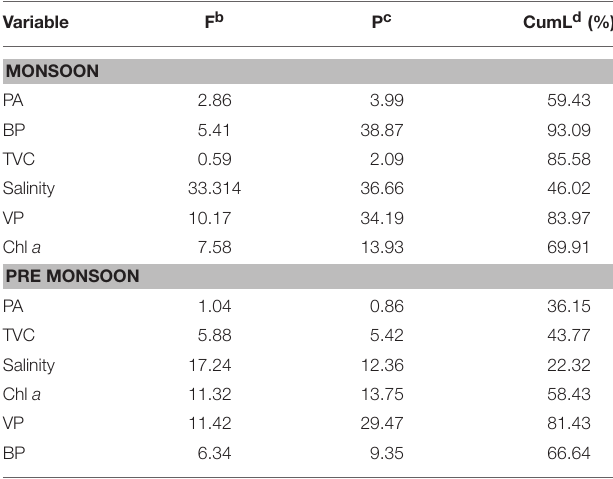
TABLE 3 | Showing distance based linear model (DistLM) on multivariate regression analysis for viral